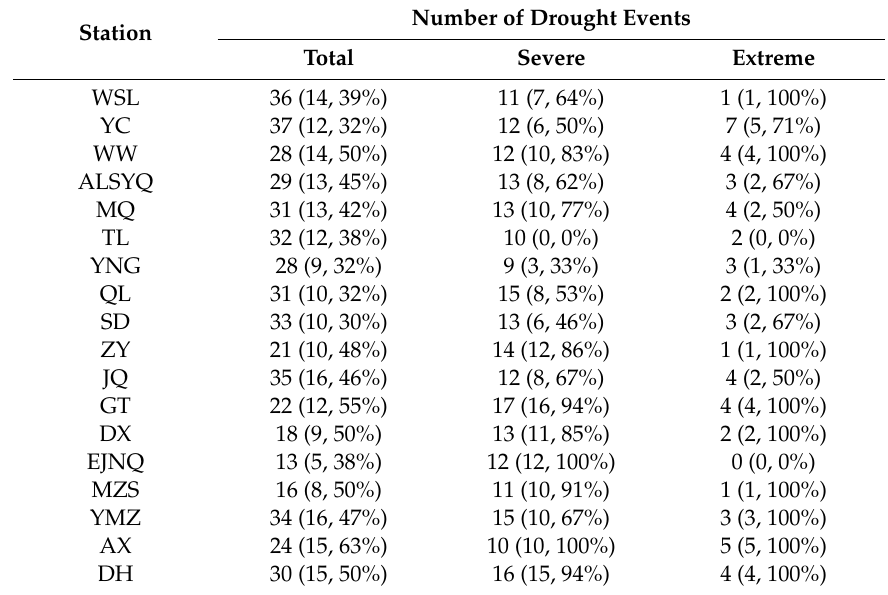
Table 5. Z-statistic values of trend analysis by using the MK test